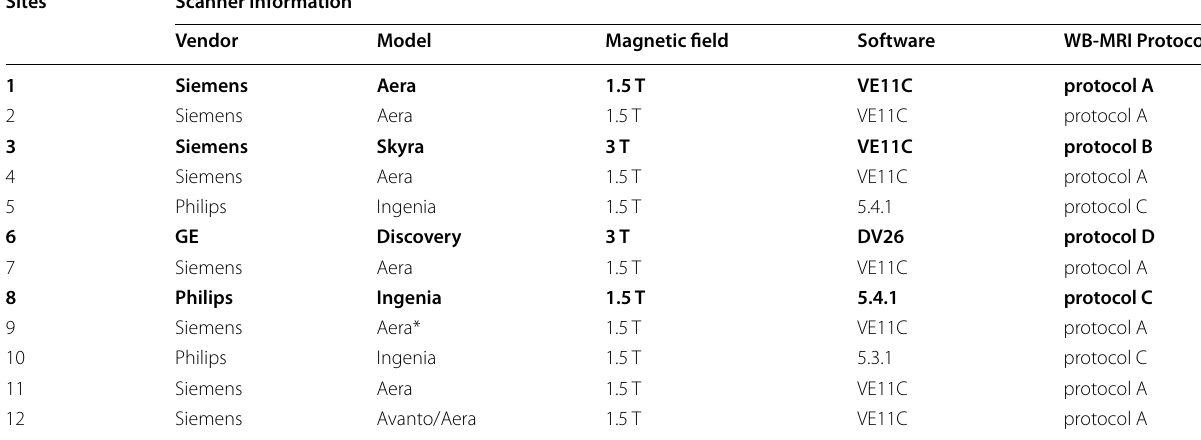
A protocol site 1 = B protocol site 3 = C protocol site 8 = D protocol site 6 =